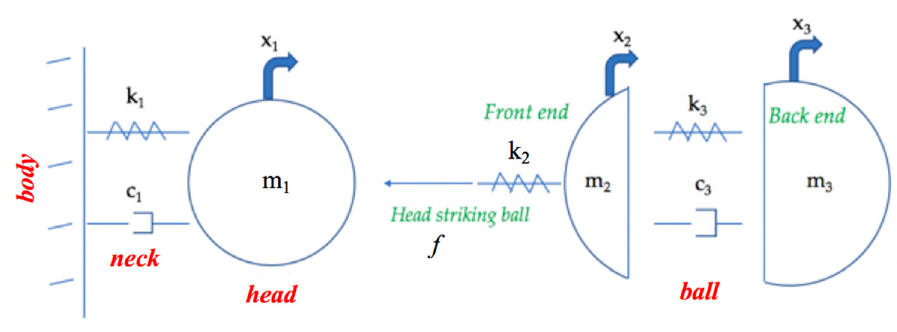
Figure 1. Proposed lumped mass representation of a soccer ball impacting a player’s